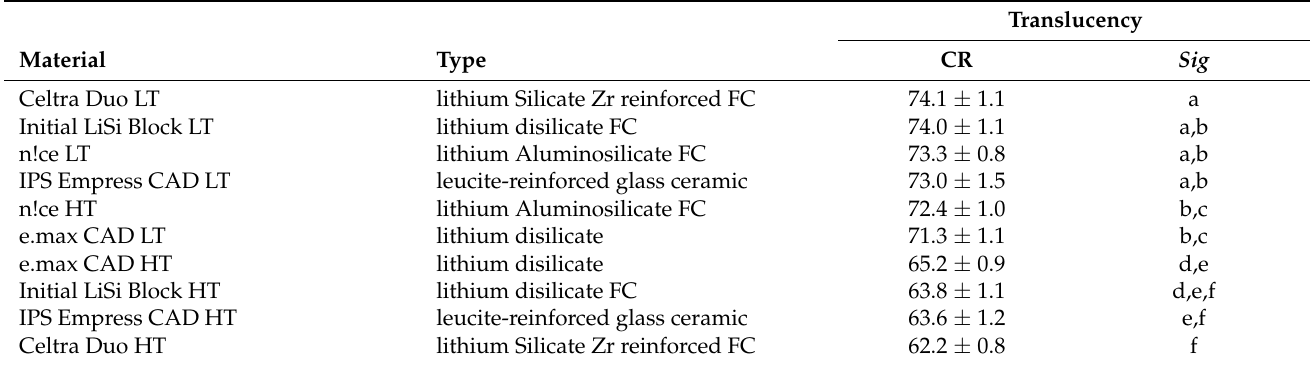
Table 4. Results of tested materials ranked by translucency